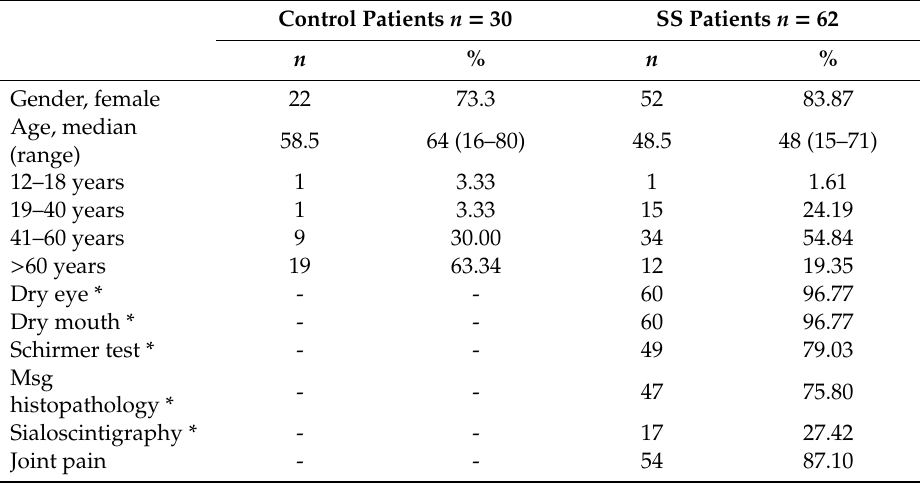
Table 1. Demographic characteristics for the total population.